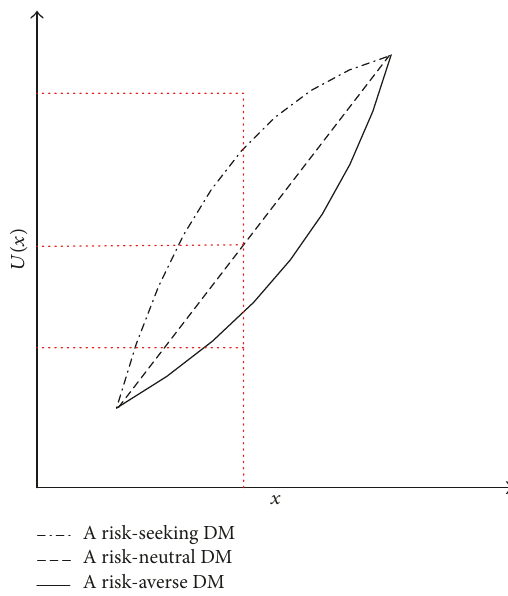
Figure 2: The behavior of DM based on quadratic utility